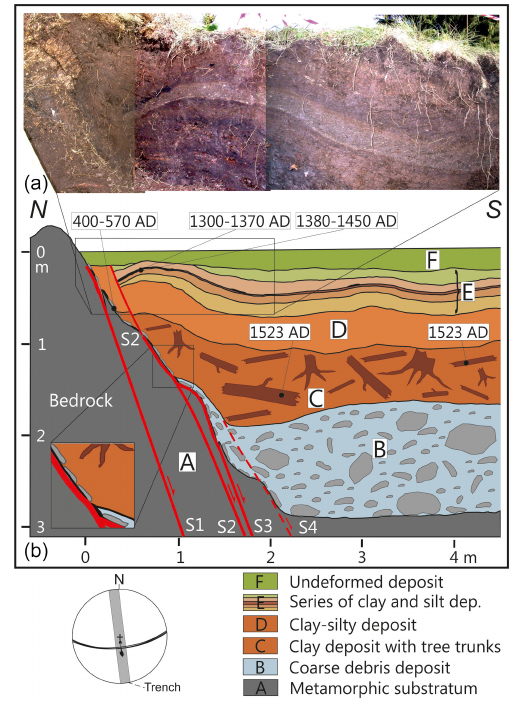
Figure 8. (a) Photo of a portion of the wall exhumed during the excavation of the artificial trench at the Bregaglia Valley trench and (b) complete log of the same wall. A series of slide surfaces off- set the bedrock and the sedimentary infill of the depression induced by the uphill-facing scarp. Note that offset increases with the age of the layers. Absolute dating was obtained by radiocarbon 14 C and dendrochronology techniques. Note the dragging of strata along slip plane S2, compatible with a small uplift of the hanging wall block located uphill of the slip planes. Stereogram (Schmidt’s projection, lower hemisphere) shows geometry of the slip planes and orienta- tion of the trench (modified after Tibaldi and Pasquaré,